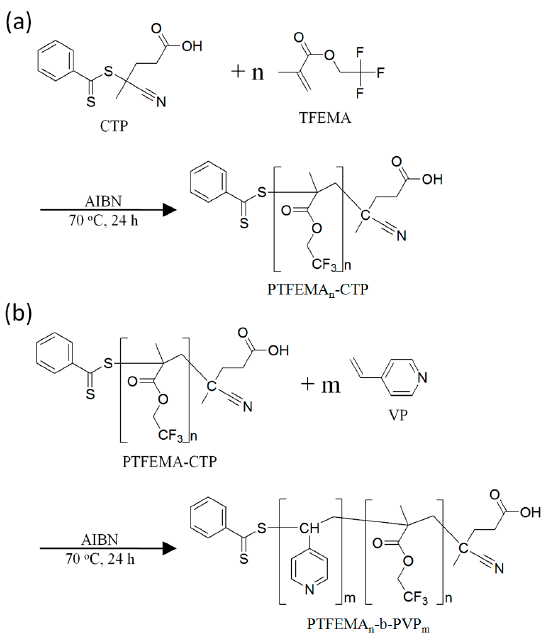
Figure 1. Schematic drawing of the mechanism for syntheses of ( a ) PTFEMA macro-RAFT agent (PTFEMA n -CTP) and ( b ) CTP: